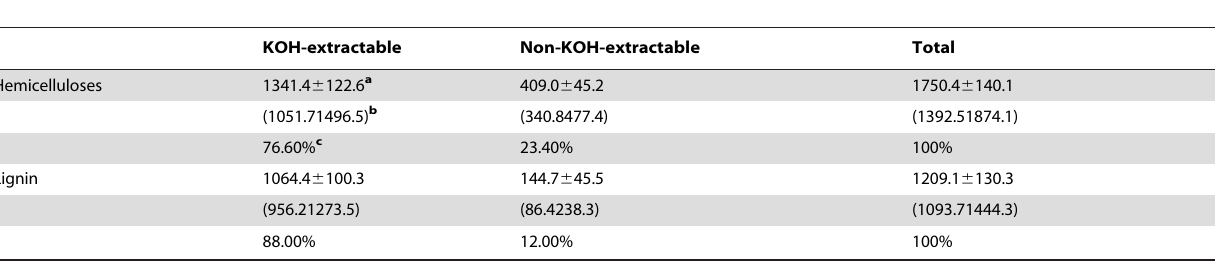
Table 3. Proportions of two types of hemicelluloses and lignin in the typical corn